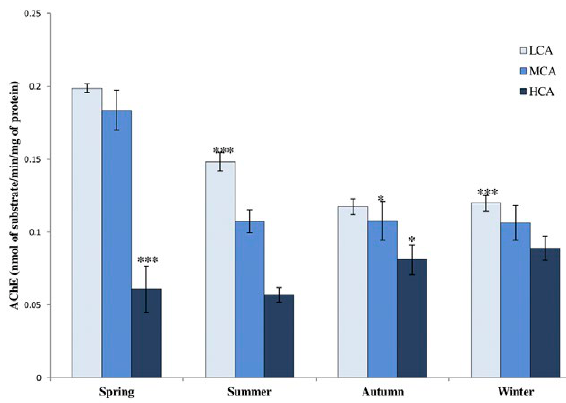
Fig. 3. – Seasonal variation of the acetylcholinesterase (AChE) ac- tivity in the digestive gland of R. decussatus sampled from three coastal Tunisian lagoons (Ghar el Melh: LCA, North lagoon: MCA and South lagoon: HCA). Results are presented as mean±SD. Sig- nificant differences are determined at 0.05 using two-way ANOVA: *p<0.05; **p<0.01; ***p<0.001.